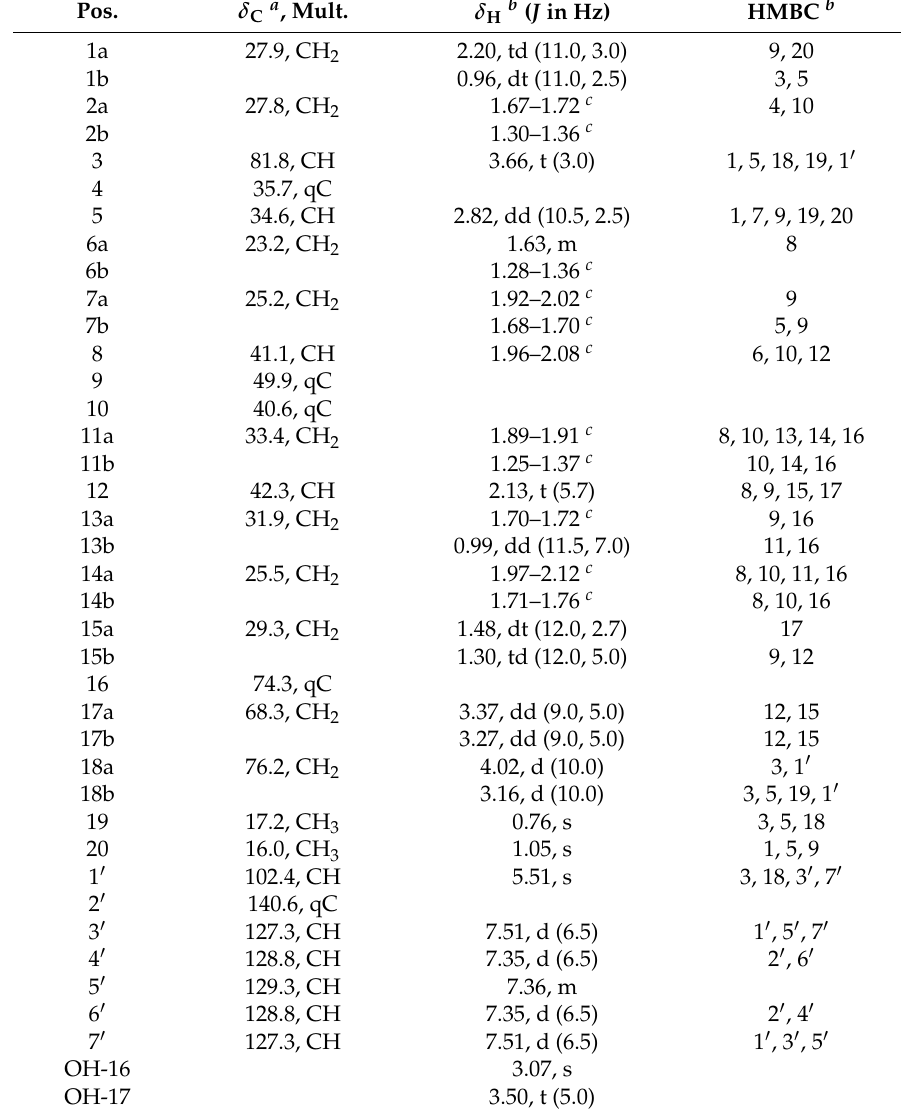
Table 1. NMR Data for 1 in Acetone- d 6.